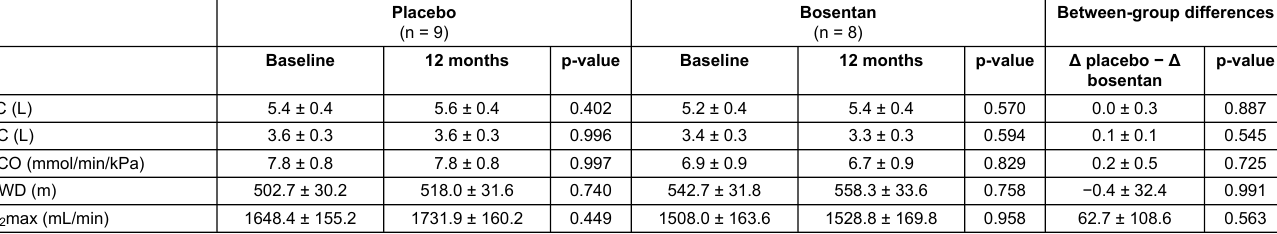
Table 2: Change from baseline to 12 months in mean absolute total lung capacity (TLC), forced vital capacity (FVC), diffusion capacity of the lung for carbon monoxide (DLCO), 6-minute walking distance (6MWD), and maximal oxygen uptake (VO 2 max).